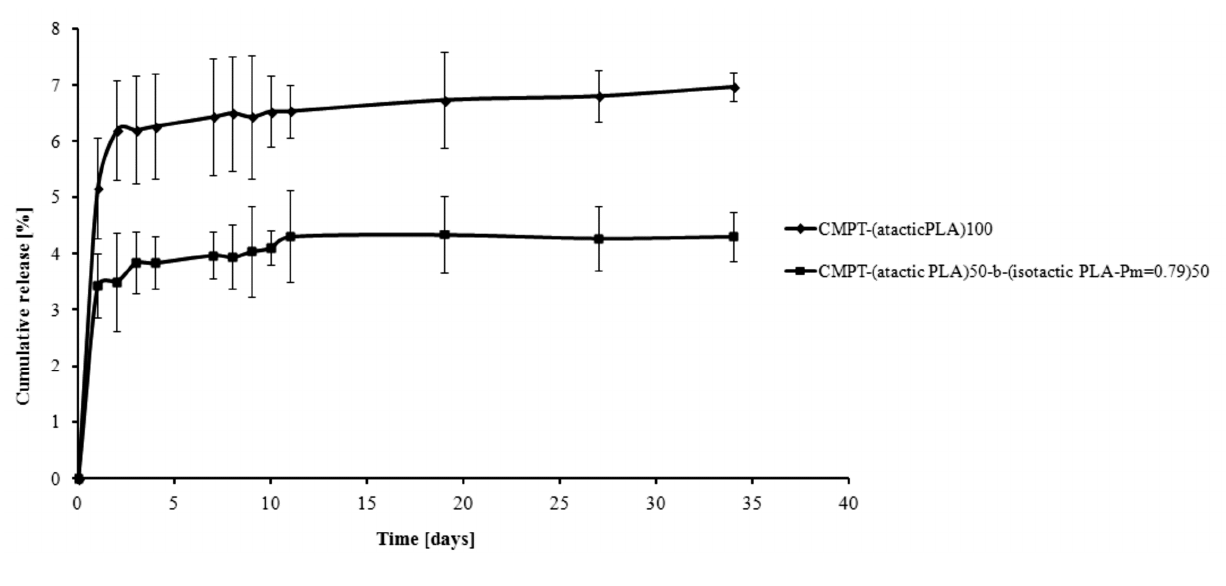
Figure 3. Release of CMPT from the CMPT-PLA conjugates at pH